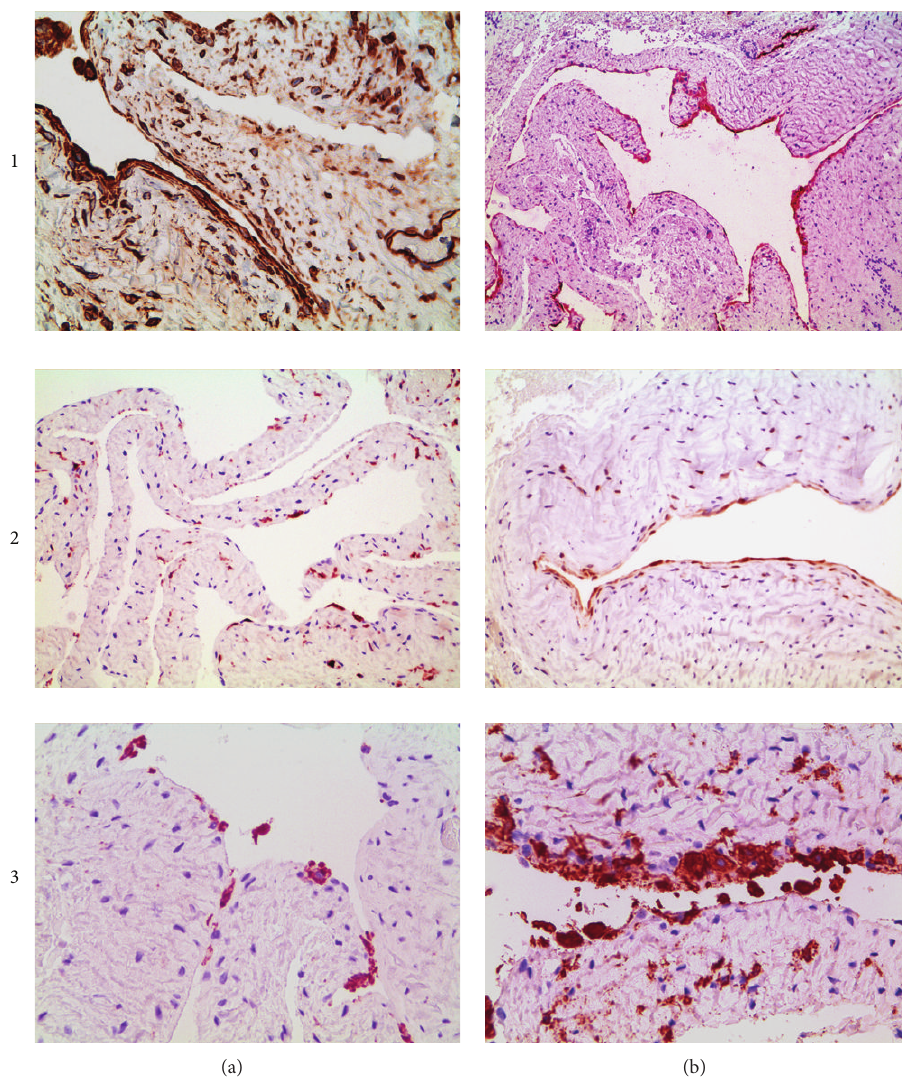
Figure 4: Immunohistochemical staining against vimentin (a1), D2-40 (b1), HSP-70 (a2), metallothionein (b2), CD68 (a3), and HLA-DR (b3) showing the immunoreactivity profile of the synovial cyst, with a lining of predominantly spindle-shaped cells (vimentin, D2-40, HSP- 80, and metallothionein positive; type B synoviocytes) and a small population of CD68 + cells (type A synoviocytes) highlighted by HLA-DR staining (VT: 250x; D2-40,200x; HSP-70: 200x; metallothionein: 250x; CD68: 250x; HLA-DR: